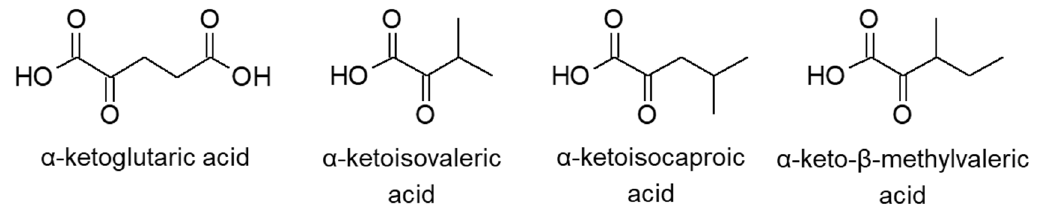
Figure 10. Chemical structures of α-keto acids.